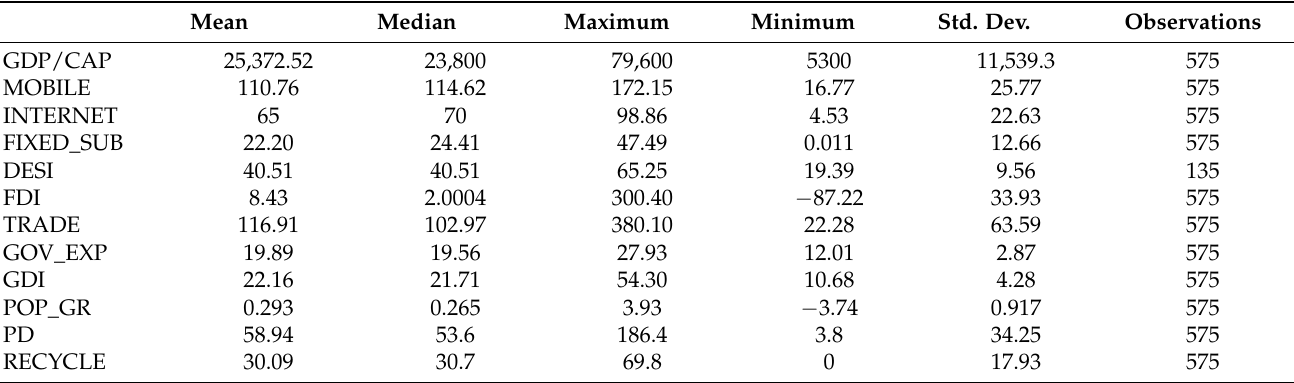
Table 2. Descriptive statistics of selected variables.